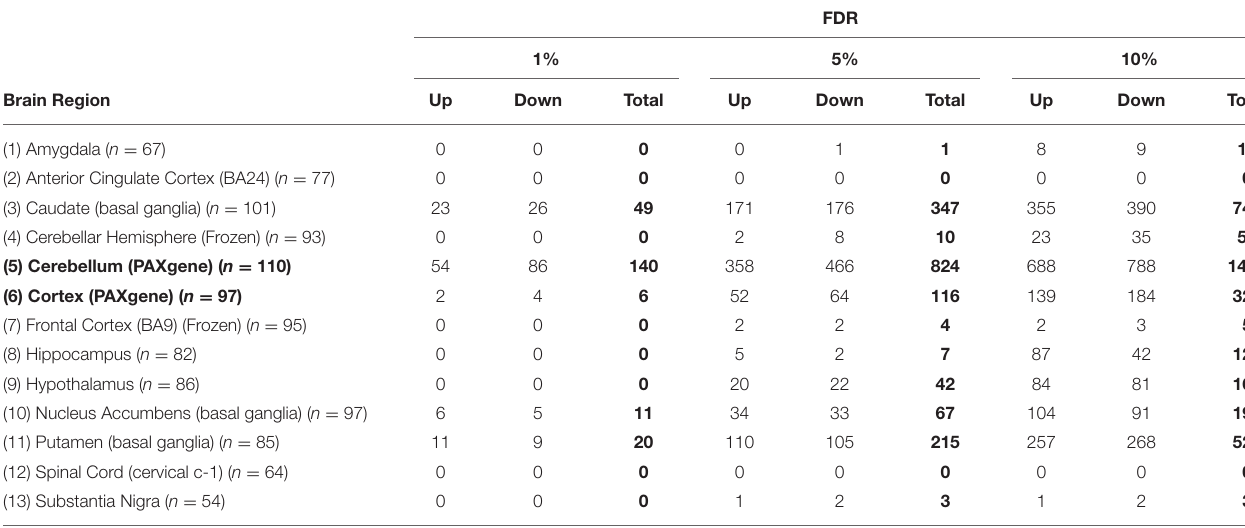
TABLE 1 | Numbers of age-related genes in 13 GTEx brain